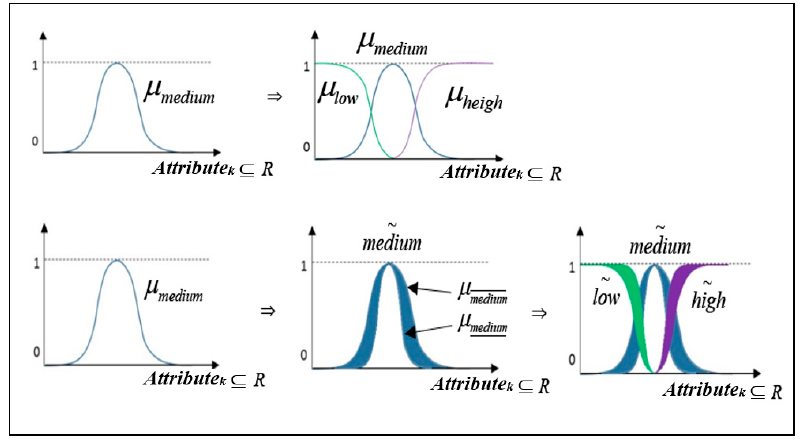
Figure 5. Type-1 and type-2 fuzzification proposal.